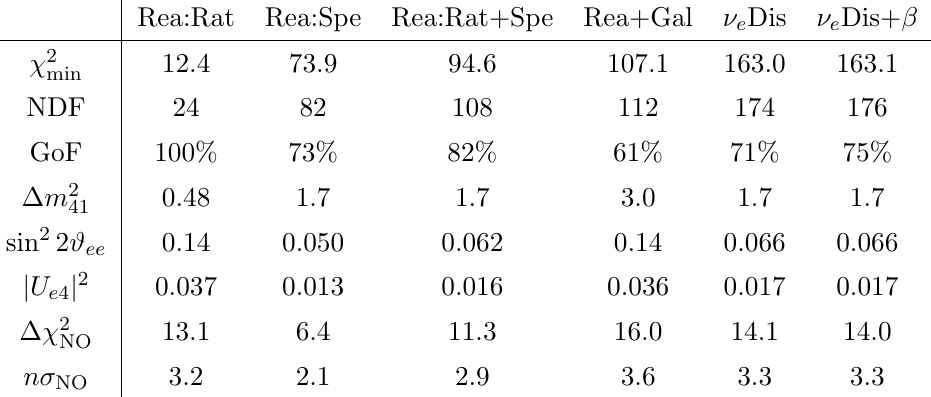
Table 4 . Results of the (cid:12)ts of (cid:23) e and (cid:22) (cid:23) e disappearance data: minimum (cid:31) 2 ( (cid:31) 2 ), number of degrees min of freedom (NDF), goodness of (cid:12)t (GoF), best (cid:12)t values of (cid:1) m 2 , sin 2 2 # ee , and j U e 4 j 2 , (cid:31) 2 di(cid:11)erence 41 (cid:1) (cid:31) 2 between the (cid:31) 2 of no oscillations and (cid:31) 2 , and the resulting number of (cid:27) ’s ( n(cid:27) NO ) for two min NO degrees of freedom corresponding to two (cid:12)tted parameters ((cid:1) m 2 and sin 2 2 # ee ). The columns 41 correspond to the (cid:12)ts of the data of reactor rates (Rea:Rat), reactor spectra (Rea:Spe), reactor rates and spectra (Rea:Rat+Spe), reactor and Gallium data (Rea+Gal), (cid:23) e and (cid:22) (cid:23) e disappearance data ( (cid:23) e Dis), (cid:23) e and (cid:22) (cid:23) e disappearance data and (cid:12) decay constraints ( (cid:23) e Dis+ (cid:12) ).